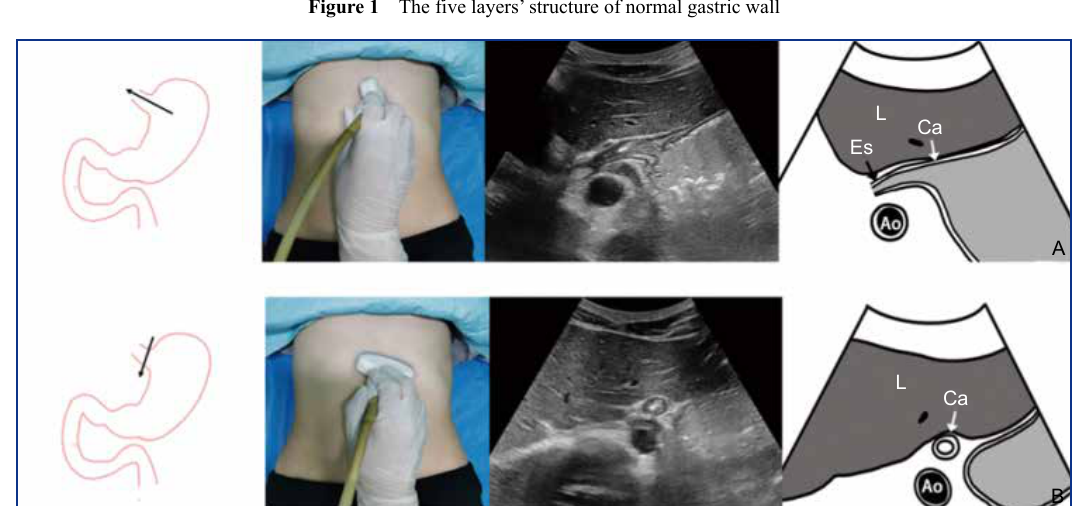
Figure 2 The imaging sections of cardia and lower esophagus. (A) The long-axis sections of the cardia and lower esophagus; (B) The short-axis sections of the cardia and lower esophagus. L, liver; Ca, cardia; AO, abdominal aorta; Es, esophagus. hypochondrial region (2) The imaging sections for the fundus (Fig. 3)